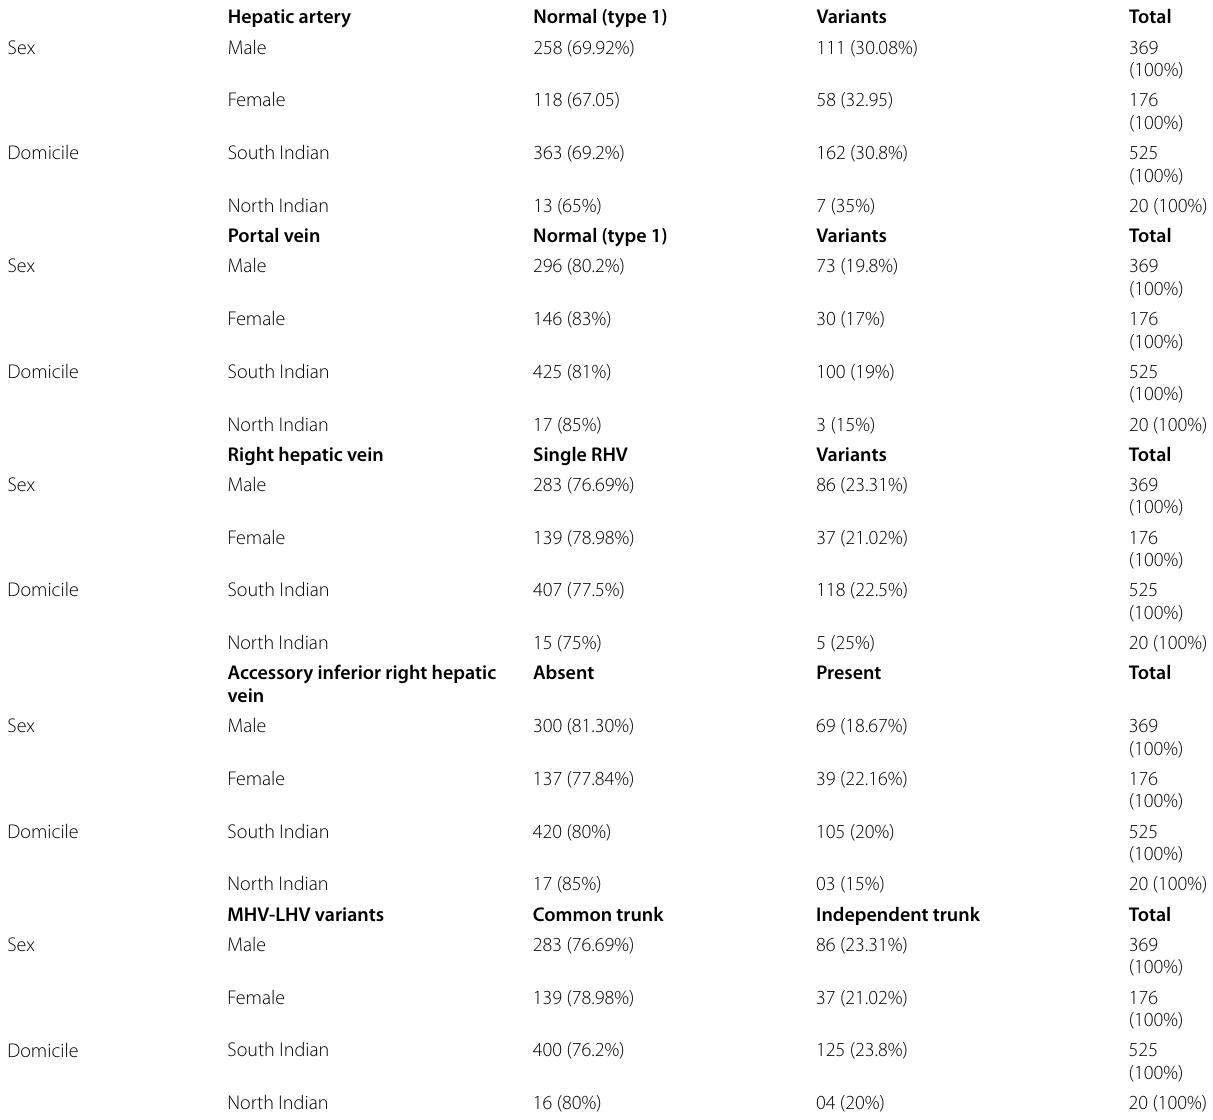
Table 3 Gender and domicile distributions of the hepatic vascular